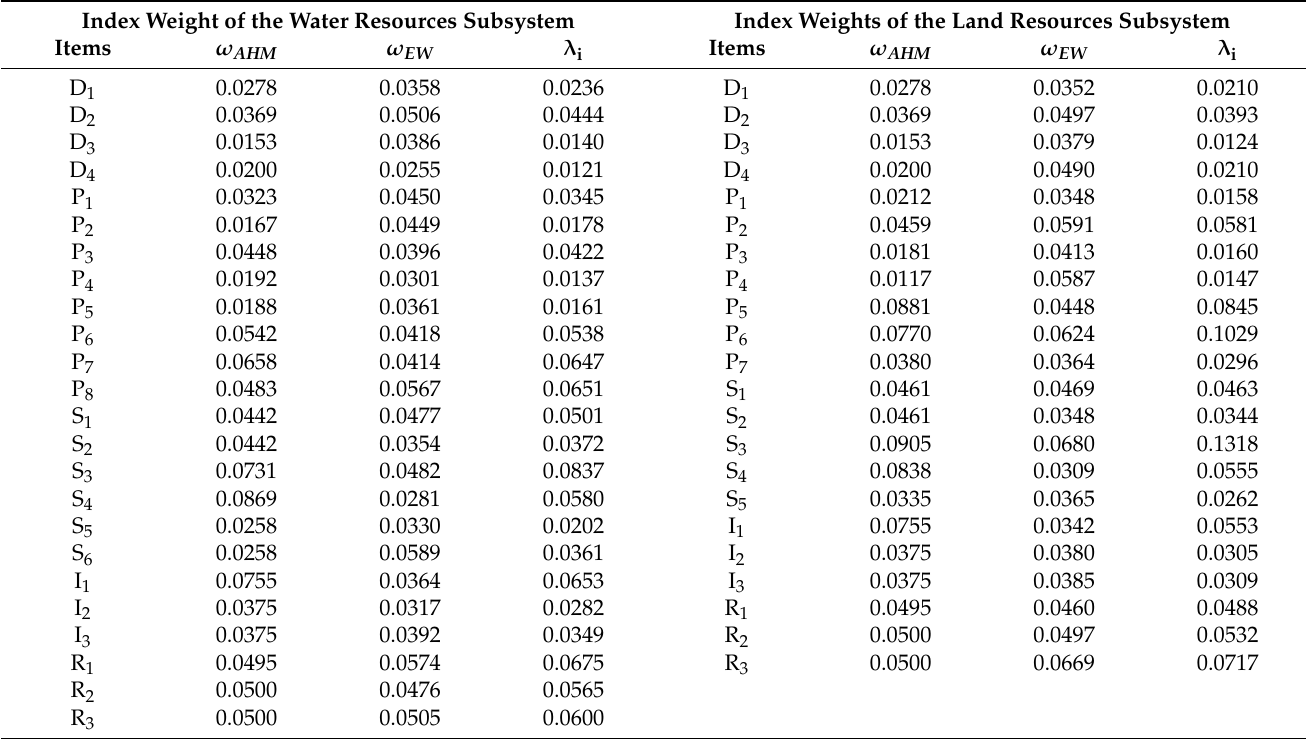
Table 4. Weights of indicators found using three methods.